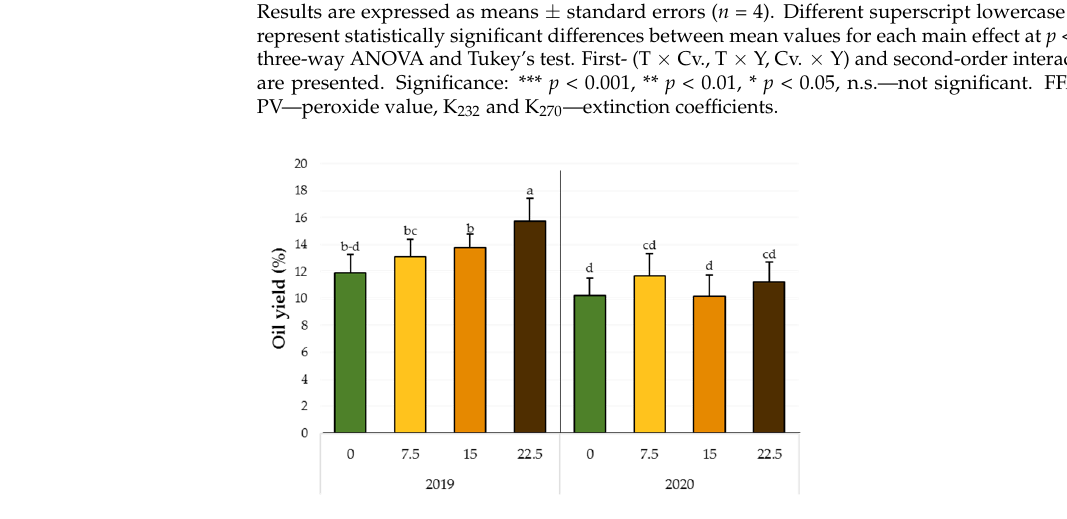
Figure 4. Multiple comparisons of the effects of treatment (T) (0, 7.5, 15, and 22.5 mL of applied SN foliar fertilizer per 1 L of water) and year (Y) (2019, 2020) on olive oil extraction yield. Different superscript lowercase letters represent statistically significant differences between mean values at p < 0.05 obtained by a three-way ANOVA and Tukey’s test.